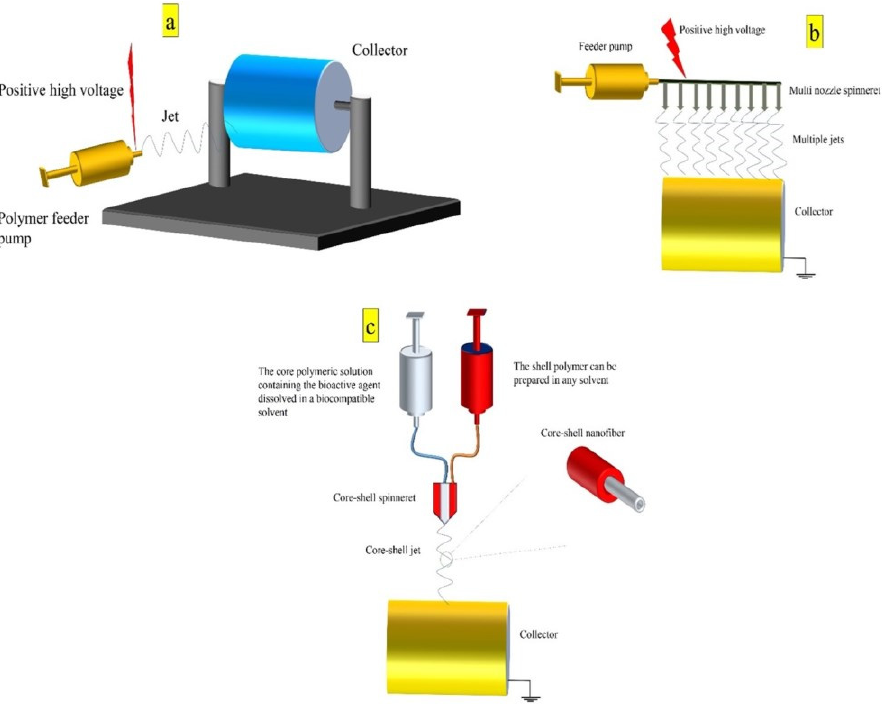
Figure 5. Schematic illustration representing ( a ) the conventional electrospinning device, ( b ) the multi-nozzle electrospinning method to increase the production yield, and ( c ) a core-shell electrospinning method to preserve the biological activity of bioactive agents.